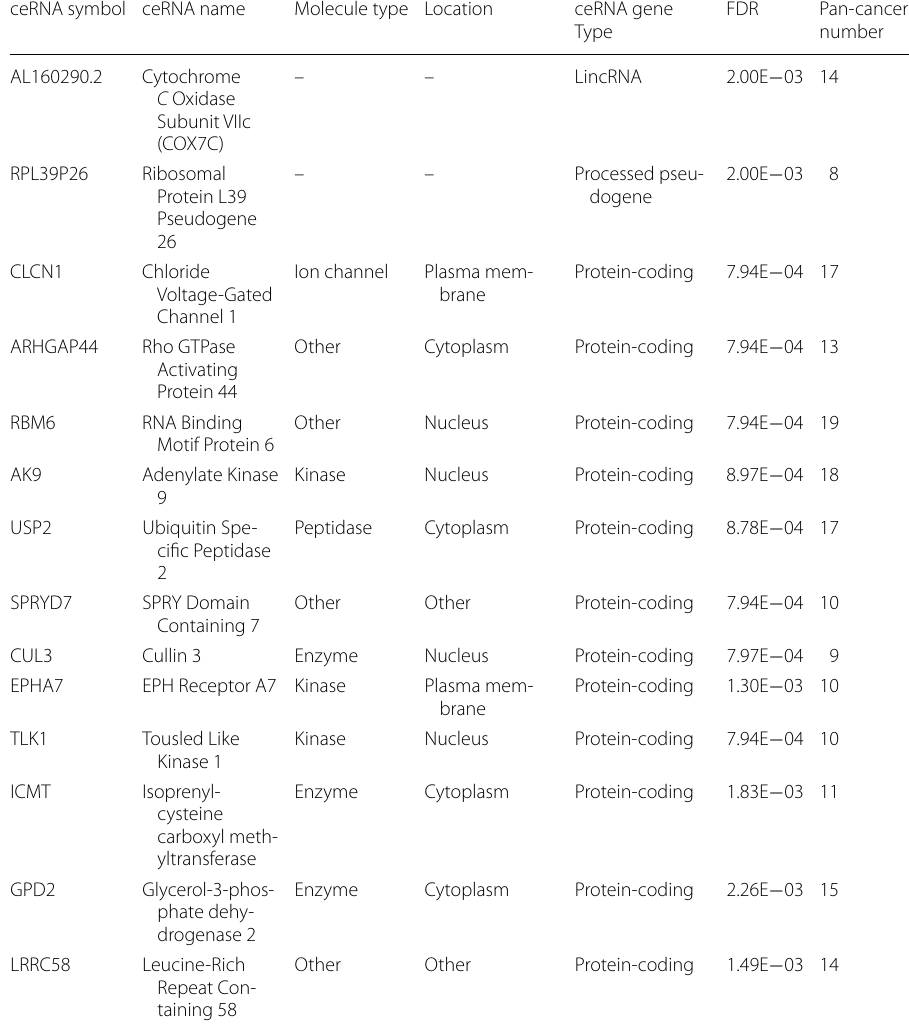
Table 5 Crosstalk between the lncRNA ( CDKN2B-AS1 ), mRNAs, and pseudogenes in competing endogenous RNA (ceRNA) network. Data source : ENCORI for RNA interactomes supported by CLIP- seq data (http:// starb ase. sysu. edu.